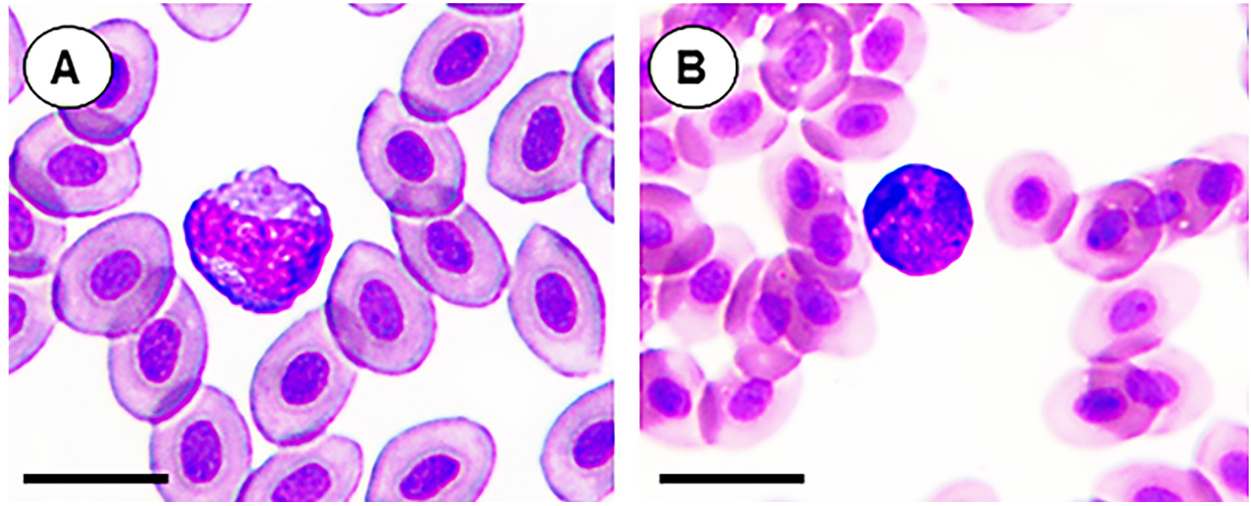
FIGURE 4 | Eosinophil and basophil in Pygocentrus nattereri from Brazilian Pantanal in May Grunwald-Giemsa-Wright staining. A . eosinophil showing irregular nucleus, loose chromatin and specific cytoplasmic granules. B . basophil surrounded by erythrocytes presenting cytoplasm filled with basophilic granulations. Scale bars = 10